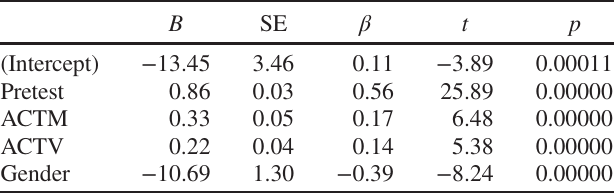
TABLE VII. Post-test model with pretest, gender, and ACT and SAT scores. B is the regression coefficient, SE the standard error, β the standardized regression coefficient, t the t statistic, and p the probability a value as large or larger than t occurred by chance.